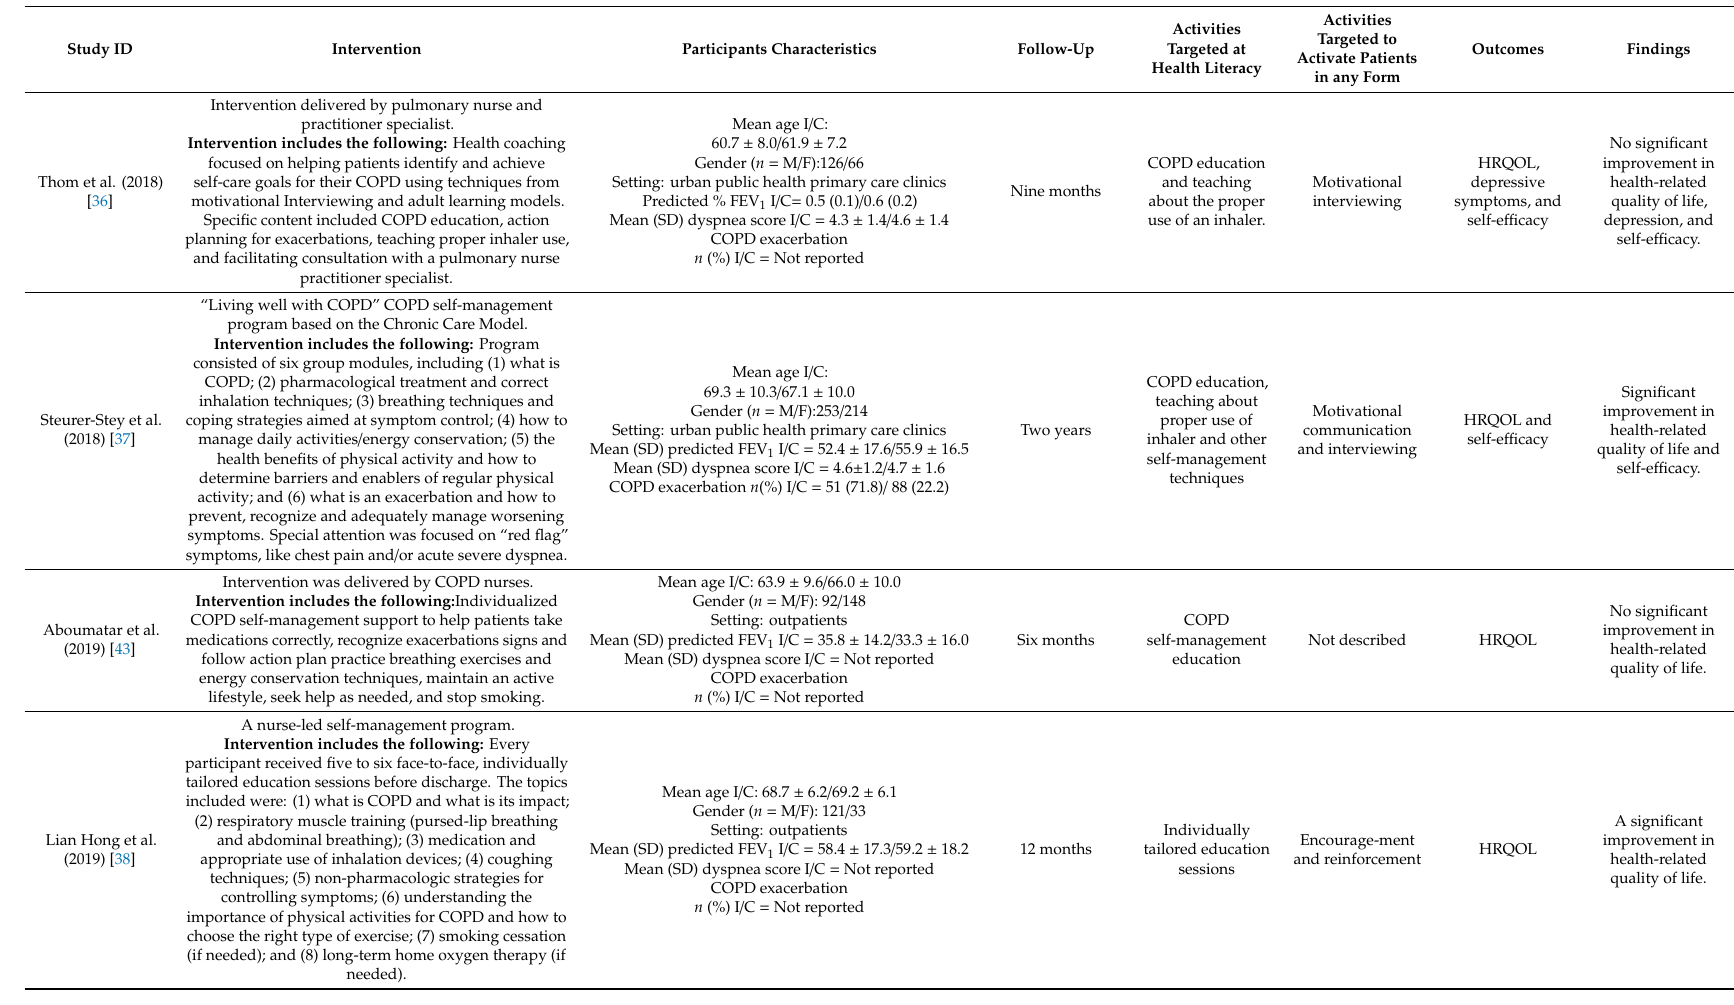
Study ID Intervention Participants Characteristics Follow-Up